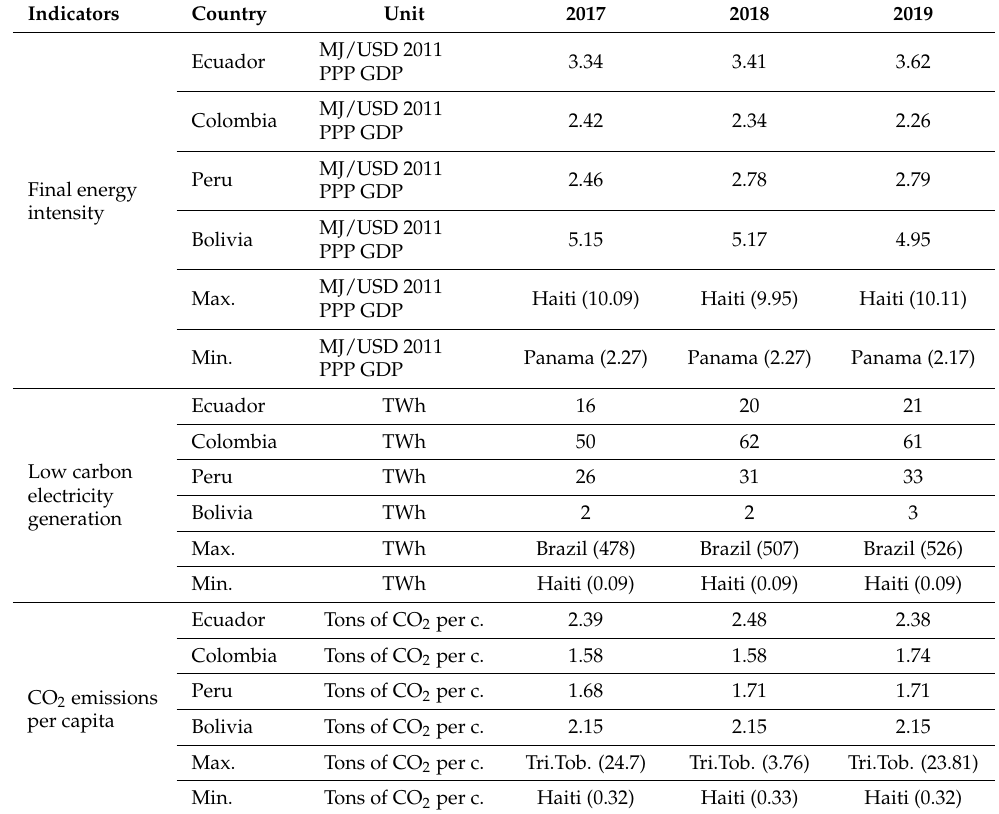
Table 9. The key indicators of the environmental sustainability dimension in the members of the Andean Community (in absolute terms).